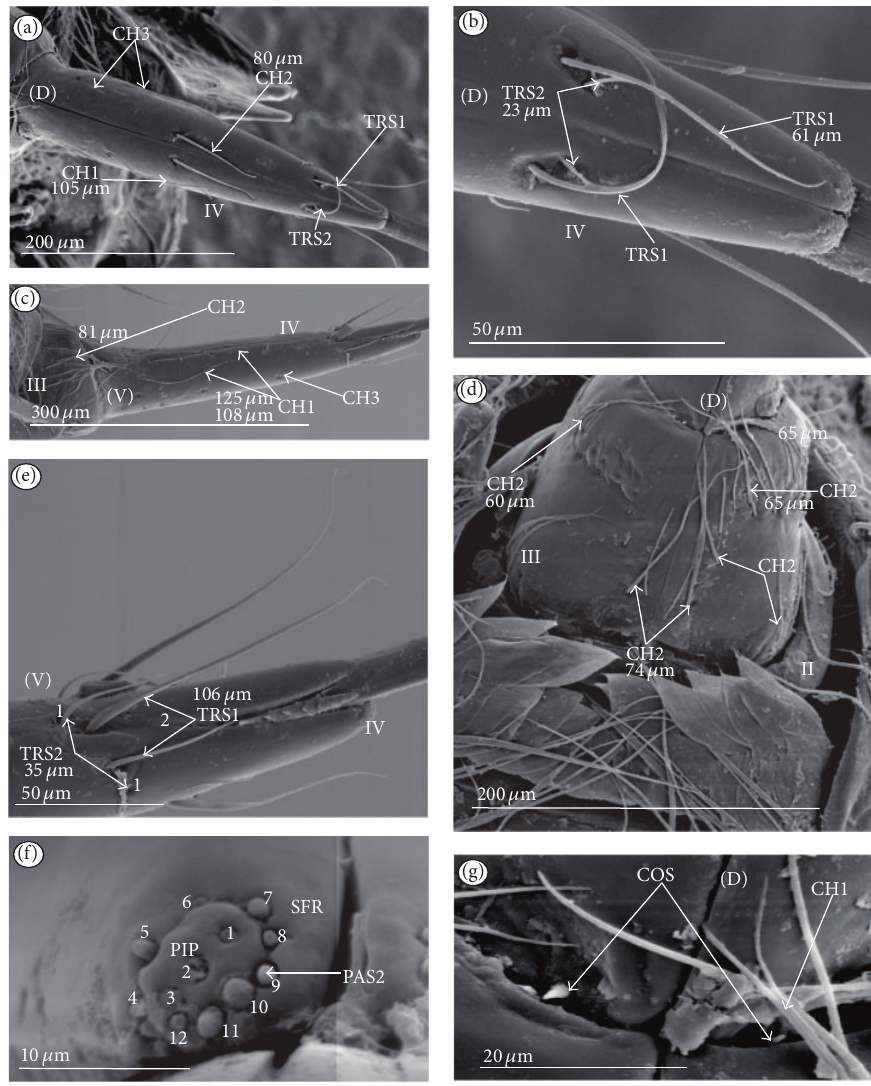
Figure 26: Types and sizes of the sensilla of the Helotrephidae ( Hydrotrephes visayasinensis ). (a) Several CH3, one CH2, and one CH1 are spread dorsally (D) oil the IV segment. (b) TRS1 (one) and TRS2 (one) are situated dorsally (D) near the apex. (c) Several CH3 and four CH1 are situated ventrally on the IV segment; several CH2 are situated on the III segment. (d) CH2 are placed near the labial groove and also near the distal edge of the III segment. (e) TRS1 (two) and TRS2 (two) are situated in two tufts, ventrally, near the apex of the labium. (f) Sensory field (SFR) with PAS2 (no. 1, 3–13) and PIP sensilla (no. 2). (g) COS are present on the dorsal surface of the IV segment, and several CH1 are present on the first